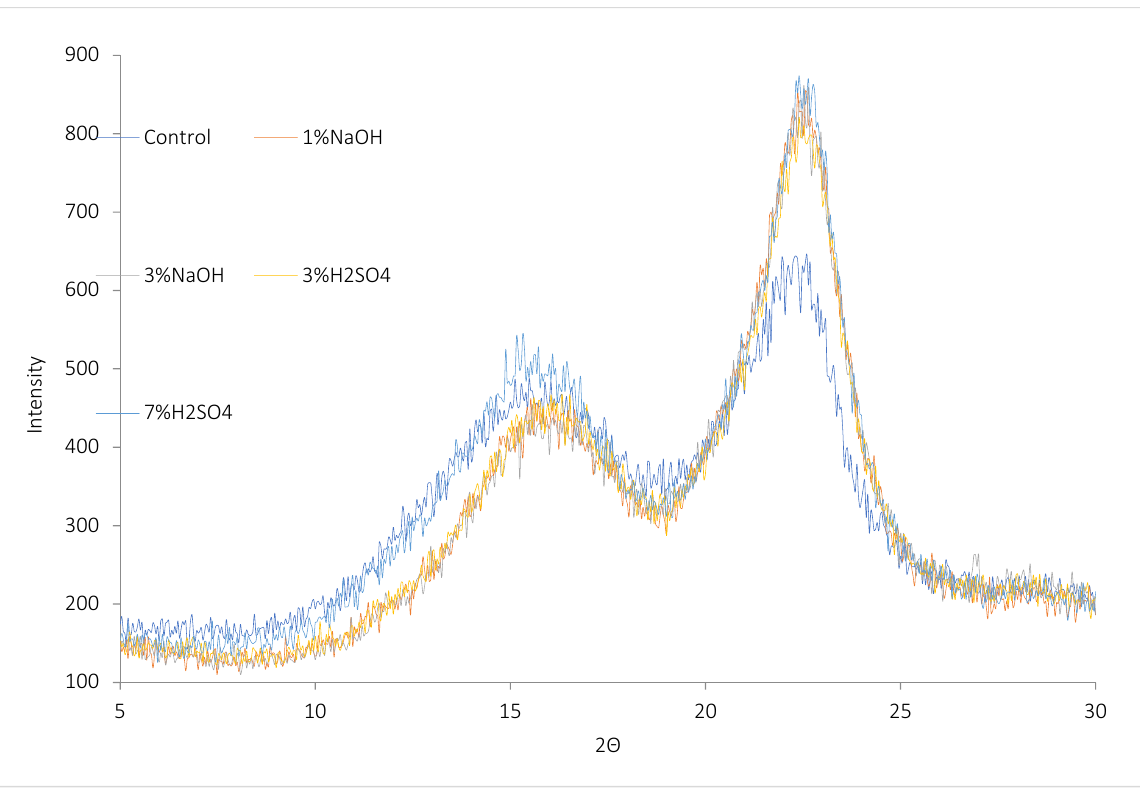
Figure 7. X-ray diffraction pattern of corn straw cellulose before and after